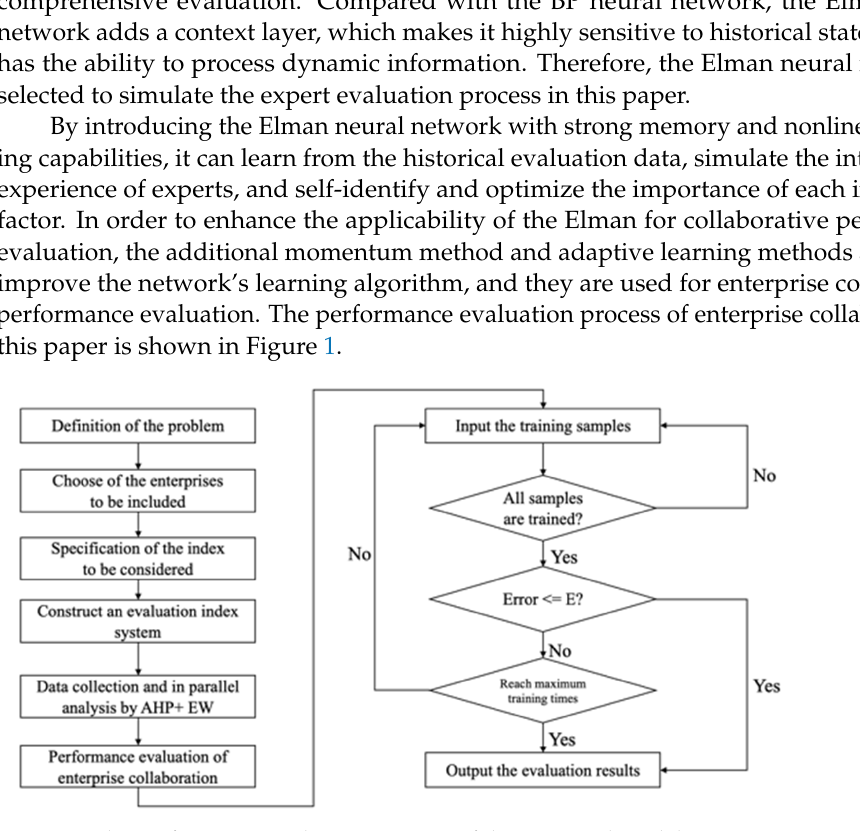
Figure 1. The performance evaluation process of the proposed model.